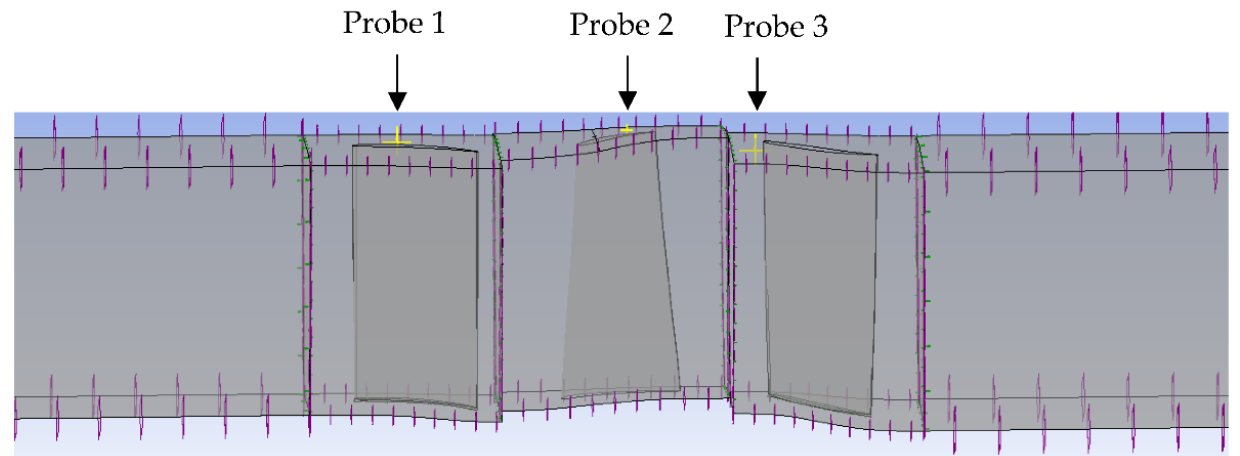
Figure 7. Locations of the numerical probes 1, 2, and 3.